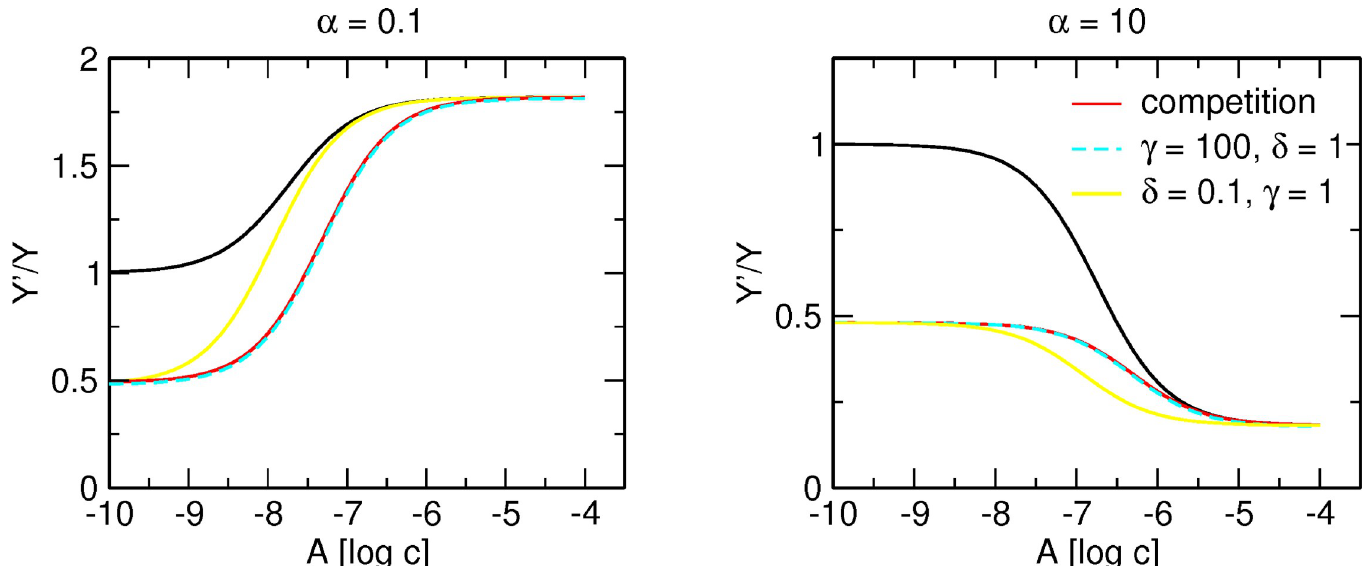
Fig 8. Comparison of competition and allosteric interaction between modulators A and B. Simulation of tracer binding (ordinate) in the presence two allosteric modulators A and B each binding to its own allosteric site (yellow line) or competing for the same allosteric site (red line), where A is either positive (left) or negative (right) and B is negative allosteric modulator. Black curve, tracer binding in the absence of modulator B. Binding of the tracer is expressed as fold over control binding in the absence of allosteric modulators. Abscissa, concentration of allosteric modulator A expressed as logarithm of molar concentration. Simulation parameters: K X = 1 nM, [X] = 1 nM, K A = 100 nM, K B = 1 μ M, β = 10, log[B] = -5.5.